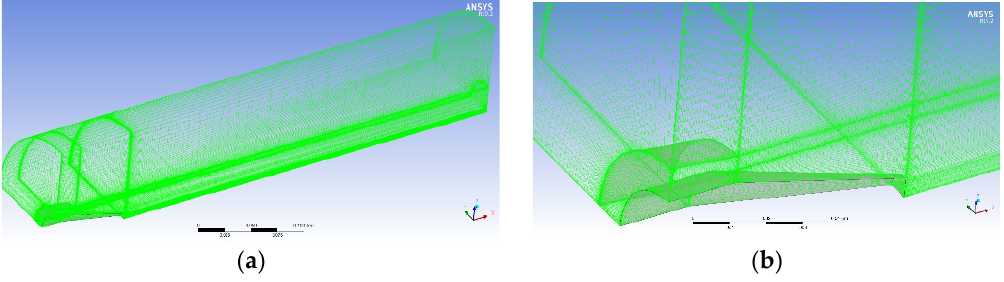
Figure 4. The mesh for the entire flow domain without ejector ( a ) and detail ( b ). For the ejector case, a structured mesh with 1,741,480 elements was created as shown in Figure